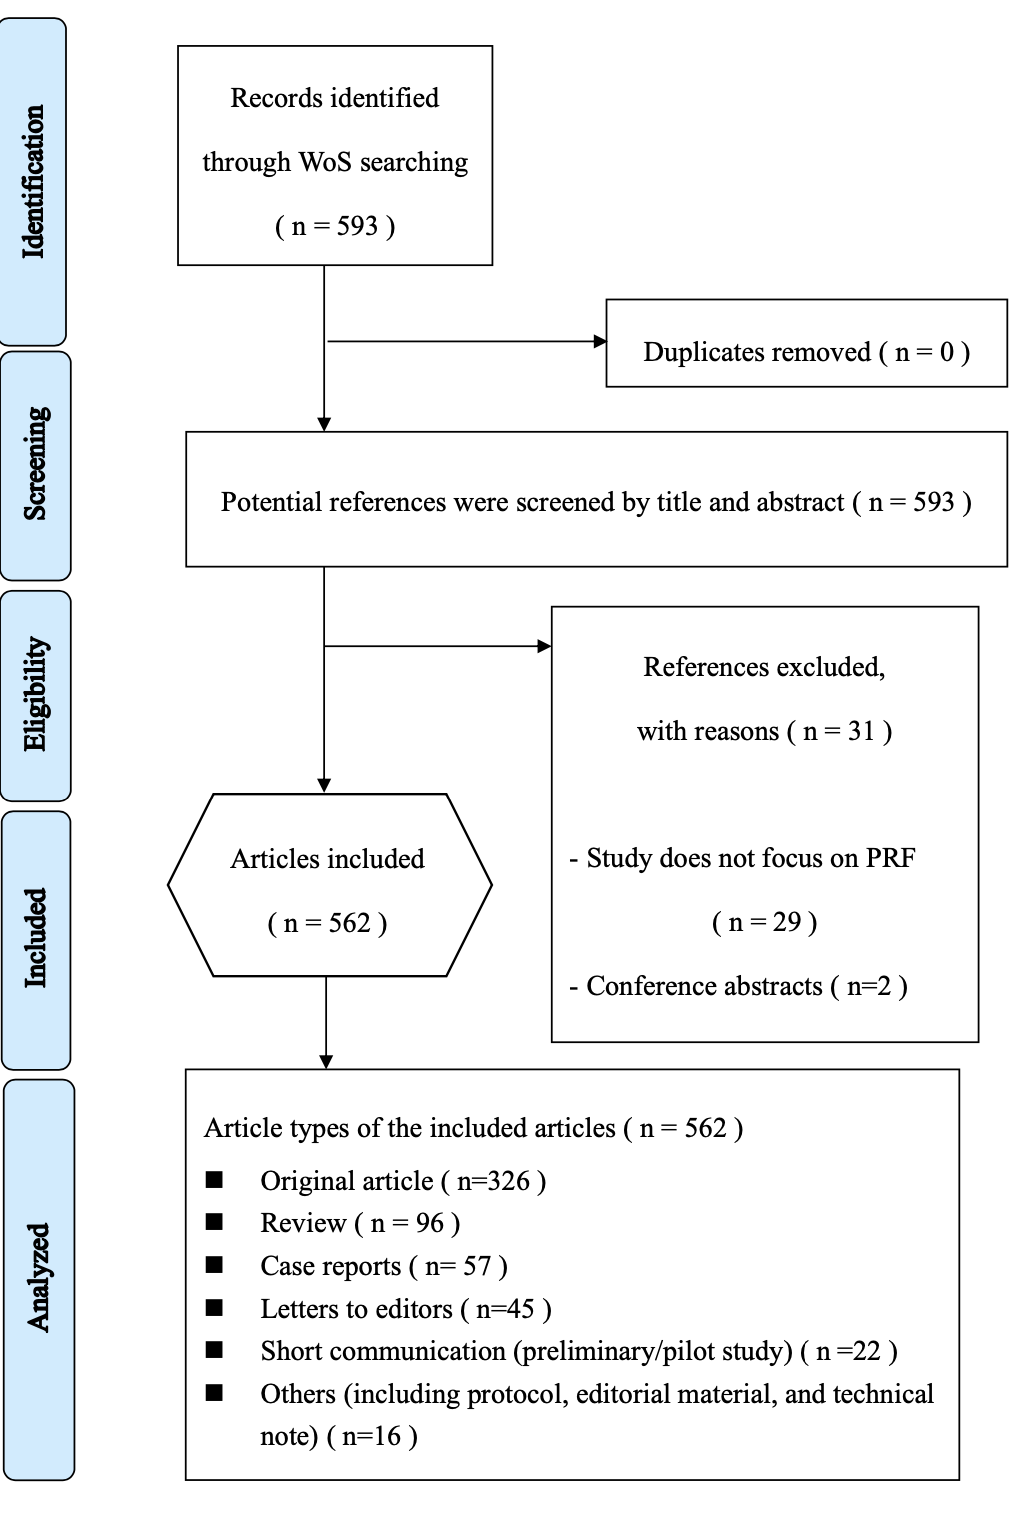
Figure 1. PRISMA selection strategy flow diagram.